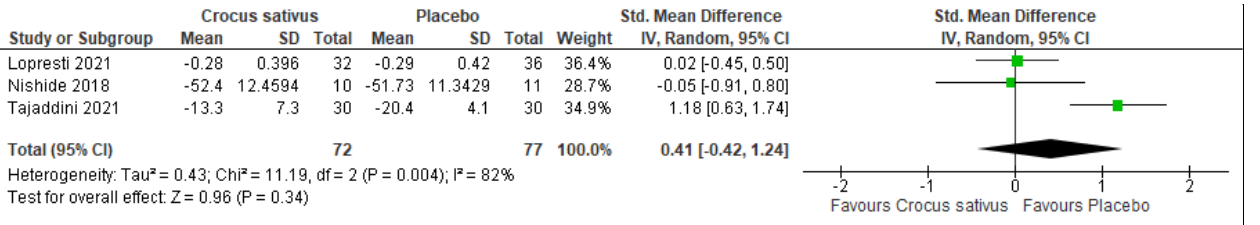
Figure 12. Forest plot for the outcome depression level [25,26,30]. Note: Line indicates confidence interval and the green square indicates effect estimate. Black diamond indicates cumulative effect estimate and its confidence interval.